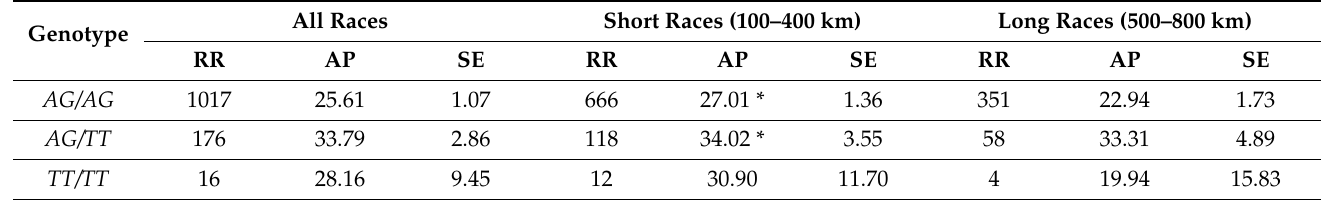
Table 1. Distribution of CRY1 genotypes and alleles in analyzed pigeons.